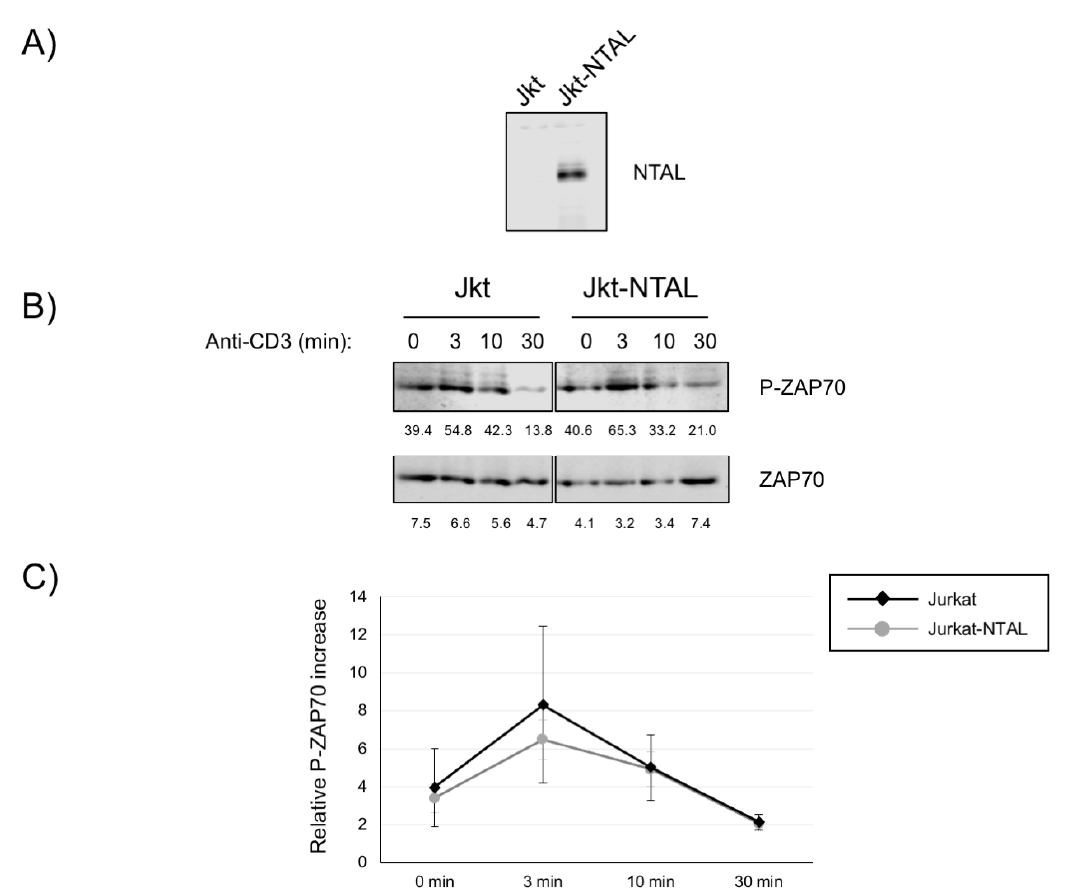
Figure 1. The effect of NTAL expression on ZAP70 phosphorylation. ( A ) NTAL expression in Jurkat cells (Jkt) or Jurkat cells lentivirally transduced with a vector coding for human NTAL (Jkt-NTAL) was assessed by Western blot of cell lysates. A representative experiment out of a total of five is shown. ( B ) Phosphorylation of ZAP70 at tyrosine residue 319 in Jurkat or Jurkat cells expressing NTAL stimulated at 37 °C with soluble anti-CD3 was detected by Western blot using antibodies against pY319-ZAP70 (upper panel) and total ZAP70 (lower panel). One representative experiment is shown. The numbers below each image represent the densitometric quantification of individual bands. ( C ) Diagram representing the quantification of four independent experiments using Jurkat cells (black) or Jurkat cells expressing NTAL (gray line). Phosphorylation levels were normalized to total ZAP70 expression and the means of fold increase of phosphorylation with regard to non-stimulated cells were graphed. Bars represent the standard error.